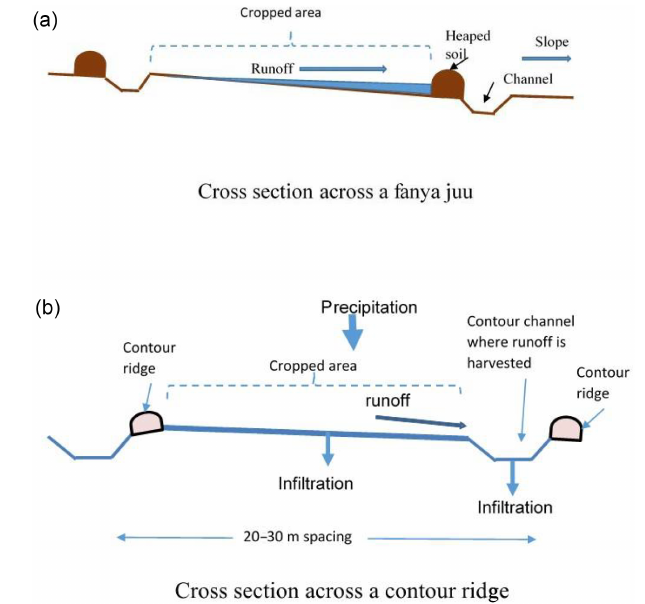
Figure 1. An illustration of the difference between a fanya juu (a) and contour ridge (b) .